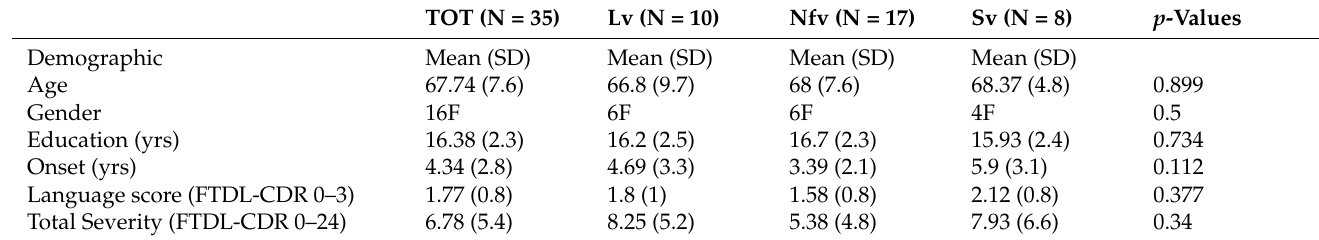
Table 1. Demographic information for all PPA patients and variants. F = female; yrs = years; Lv = Logopenic variant of PPA; Nfv = nonfluent variant of PPA; Sv = semantic variant of PPA; FTLD-CDR = fronto temporal lobar degeneration-specific Clinical Dementia Rating. TOT (N = 35)